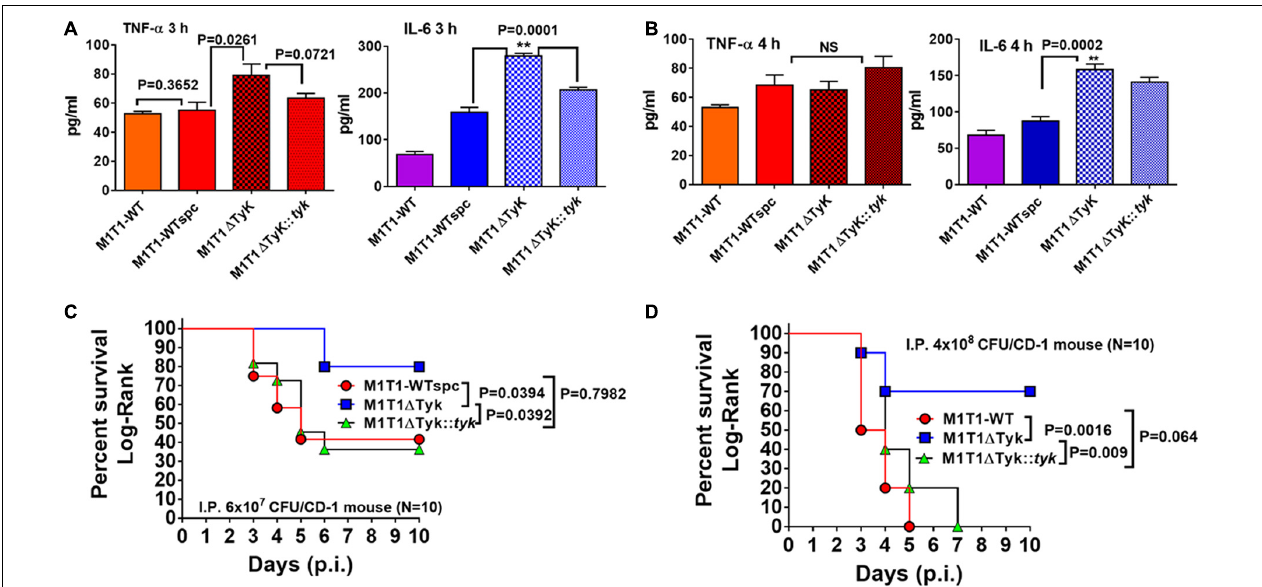
FIGURE 7 | Determination SP-TyK in GAS virulence. (A) Quantitative analyses of the secretion of TNF- α and IL-6 using the supernatant of A549 cell lines co-cultured with various GAS strains for 3 and 4 h in CO 2 incubator at 37 ◦ C, employing the sandwich ELISA method-based TNF-(B.D. optiEIA) and IL-6 (RandD) Detection kits. The supplied purified TNF and IL-6 as part of the kits were used as respective internal standards for the final quantification of the TNF and IL-6 per the instructions of the manufacturer. The bar diagrams represent average values ± S.D. obtained from three independent experiments with duplicate technical repeats. p < 0.05 indicates a significant difference. (B) The key role played by SP-TyK in virulence as determined by in vivo mouse intraperitoneal (i.p.) infection model. Percent survival of CD1 mice (10–12 mice/group) infected i.p with M1T1-WT, M1T1 (cid:49) TyK, and M1T1 (cid:49) TyK:: tyk GAS strains using two different infection doses [ (C) 6 × 10 7 CFU/mouse, (D) 4 × 10 8 CFU]. Sham-infected (PBS only) and GAS strain-infected mice were observed for 10 days post-infection (p.i.). All sham-infected mice survived and the mice infected with control M1T1-WT, M1T1-WTspc, and M1T1-WTspc/pDC strains (4 × 10 8 CFU per mice, N = 5) died within 4–5 days (Data not shown). Percent survival was evaluated statistically by the Log-Rank test using GraphPad Prism 6 software. ** p < 0.05 was treated as a significant